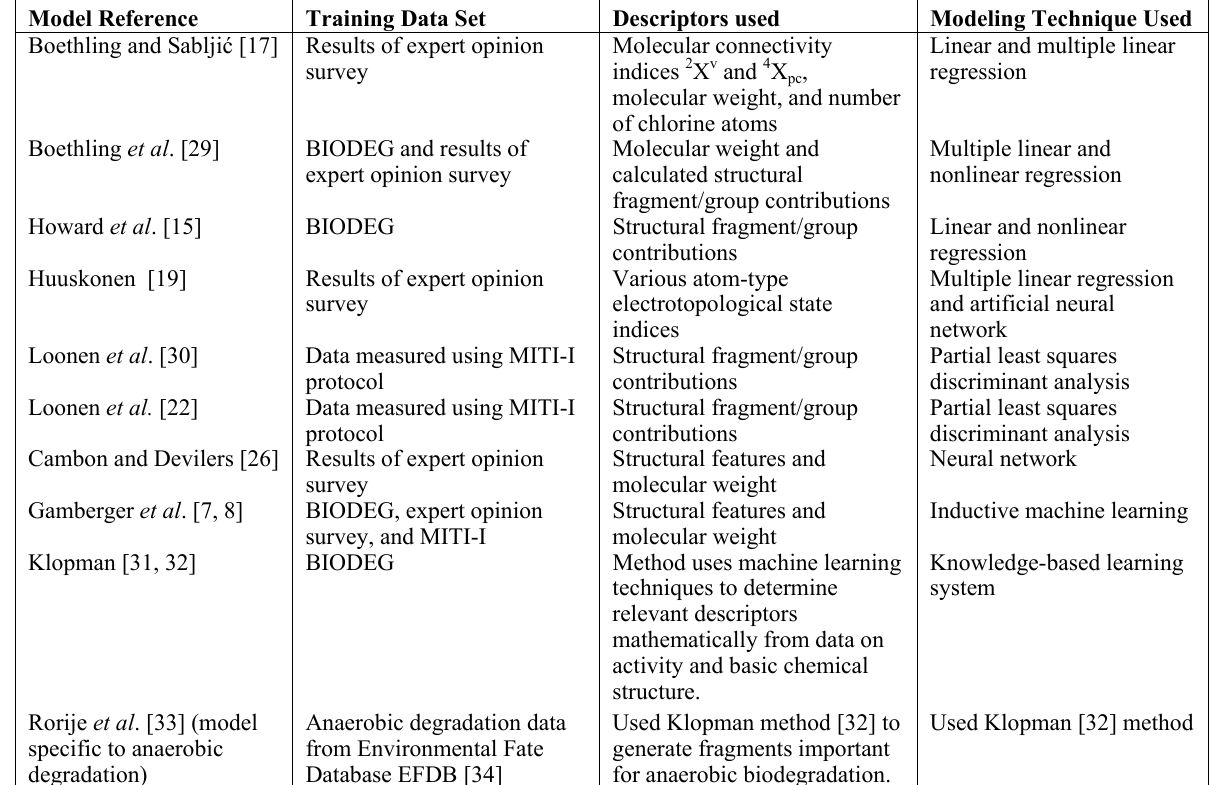
Table 2. Examples of Published Biodegradation Models Representative of Common Modeling